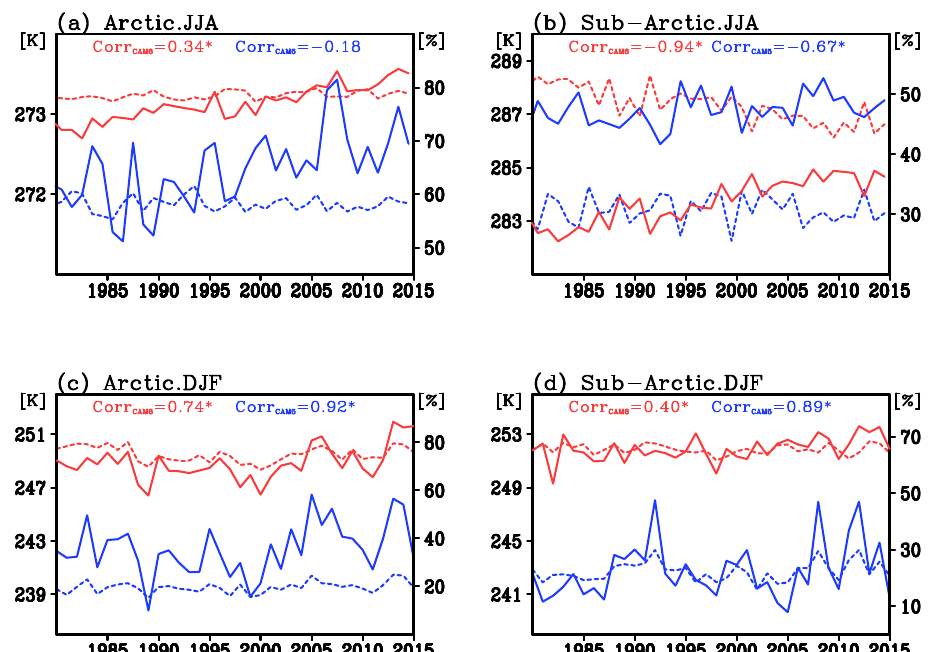
Figure 9. Interannual time series of the surface air temperature (SAT, solid line) and low cloud fraction (LCF, dotted line) averaged over ( a , c ) the Arctic and ( b , d ) the sub-Arctic region during ( a , b ) JJA and ( c , d ) DJF from CAM6 (red lines) and CAM5 (blue lines). “Corr xx = XX” indicates the correlation between SAT and LCF for CAM6 (red) and CAM5 (blue). The asterisks indicate statistical significance ( p < 0.05).